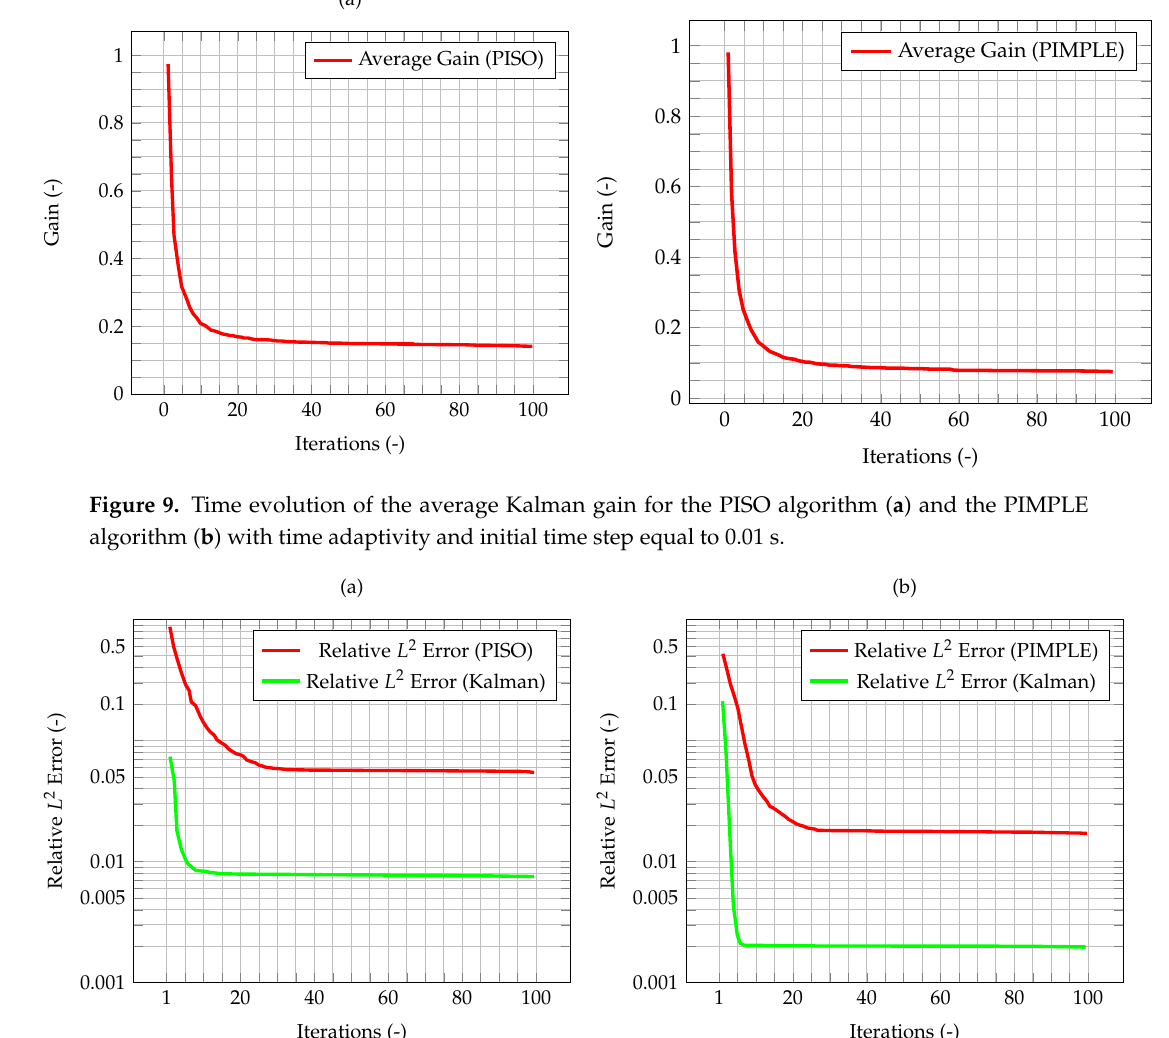
Figure 10. Time evolution of the normalized L 2 error for the PISO ( a ) and the PIMPLE algorithm ( b ) with time adaptivity and initial time step equal to 0.01 s. In both cases, the red lines represent the difference between the reference solution and the one computed on the coarser grid without correction, whereas in the green ones the coarser solution is corrected by the